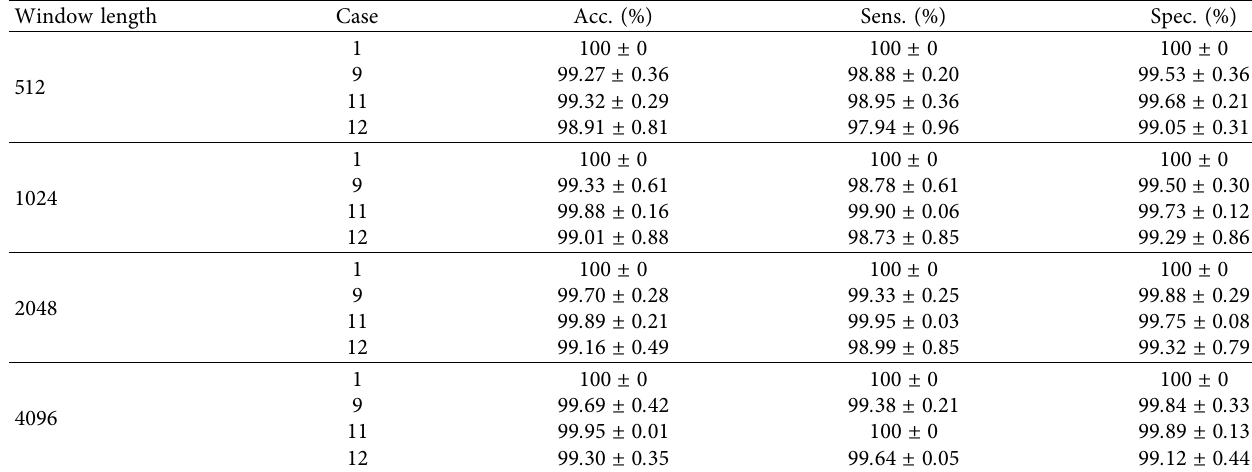
Table 6: Comparison of classifcation accuracy, sensitivity, and specifcity using diferent lengths of the EEG signal segment (mean- +standard division).